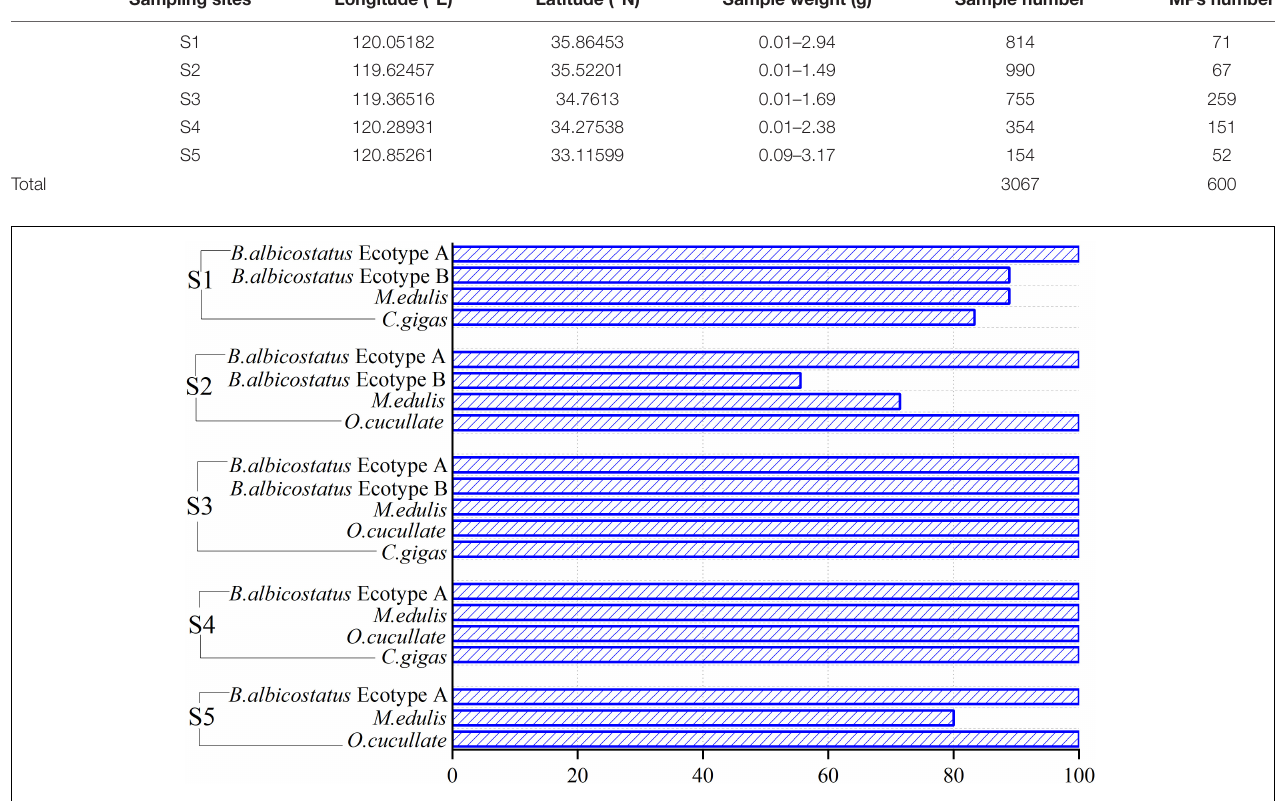
FIGURE 2 | Microplastic (MP) detection rates at five sampling sites; 100% of the sessile organism groups from S3 to S4 were